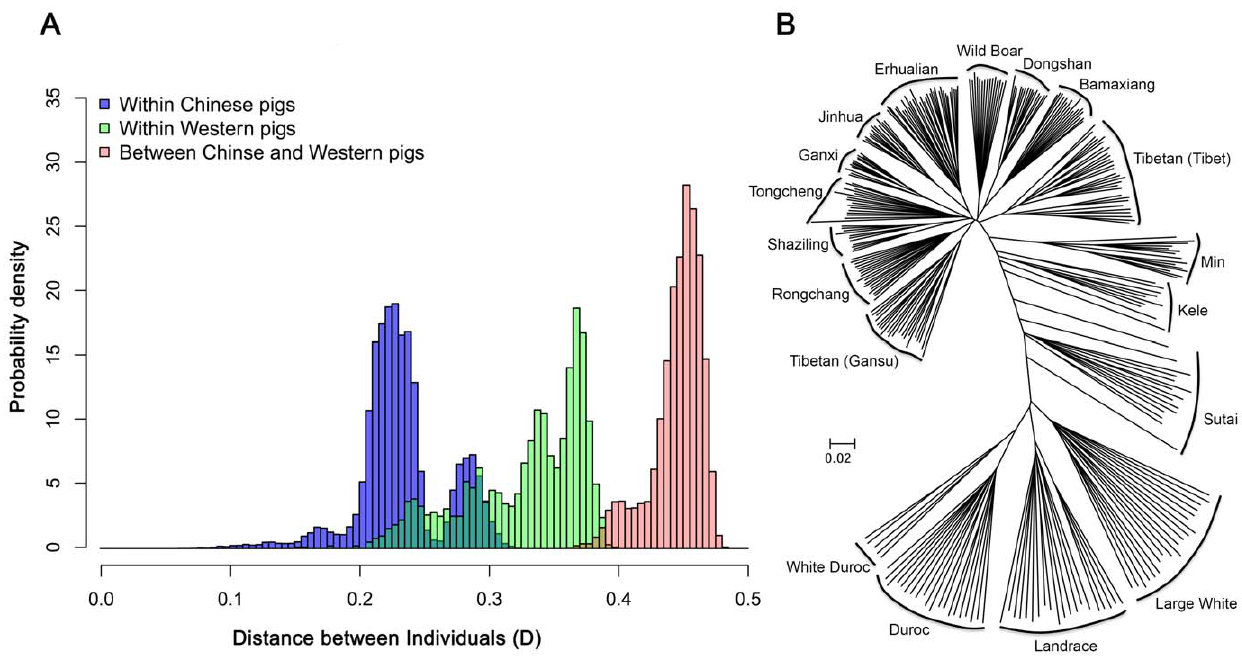
Figure 2. Genetic diversity within and between Chinese and Western pigs. (A) The genetic distance (D) between pairs of animals. Blue bars represent D within Chinese pigs; green bars represent D within Western pigs; red bars denote D between Chinese and Western pigs. (B) The neighbor-joining tree of the tested populations based on genome-wide allele sharing.